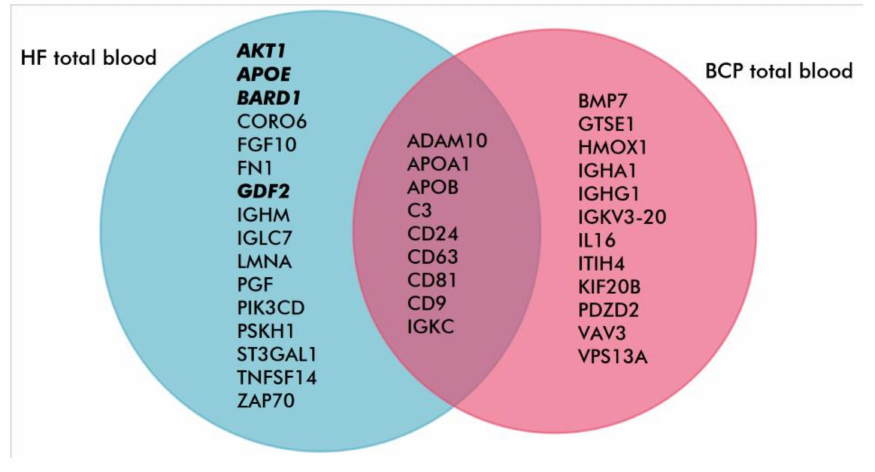
Figure 7. Venn–Euler diagram of exosomal proteins associated with cell migration (blood from HFs and BCPs). Proteins that suppress migration are in